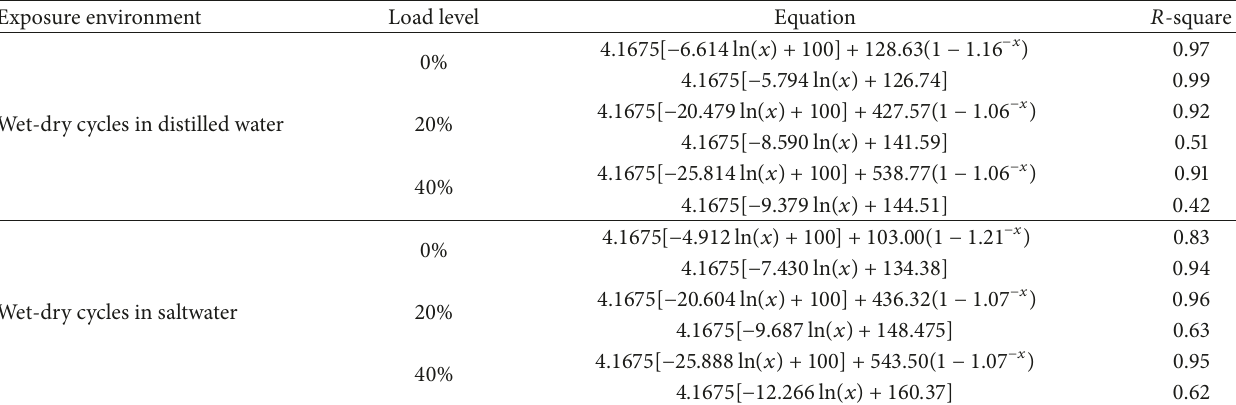
Table 3: Predictive equations for tensile strength.